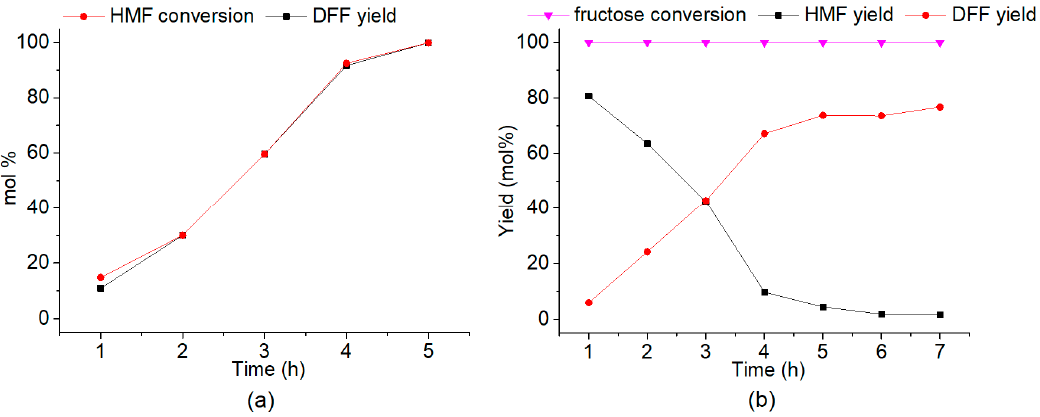
Figure 5. ( a ) Time profile for the aerobic oxidation of HMF to DFF over the 40-PMo 12 / F 3 -PAN catalyst. ( b ) Time profile for the “one-pot” and “one-step” conversion of fructose to DFF over the 40 -PMo 12 / F 3 -PAN catalyst. Reaction conditions: 35 mg HMF or 45 mg fructose, 5 mg 40 -PMo 12 / F 3 -PAN catalyst, 1 mL DMSO, 433 K, in air.